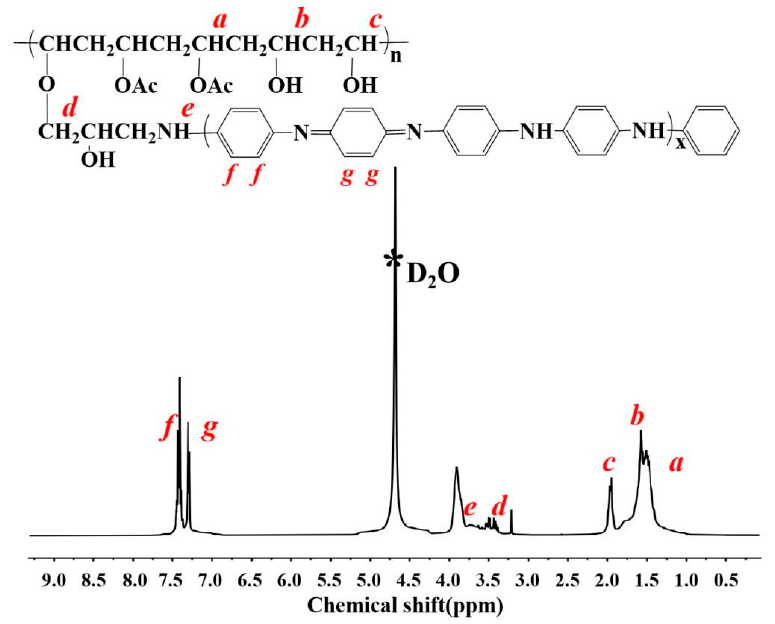
Figure 2. 1H NMR of graft copolymer PVA-g-PANI.